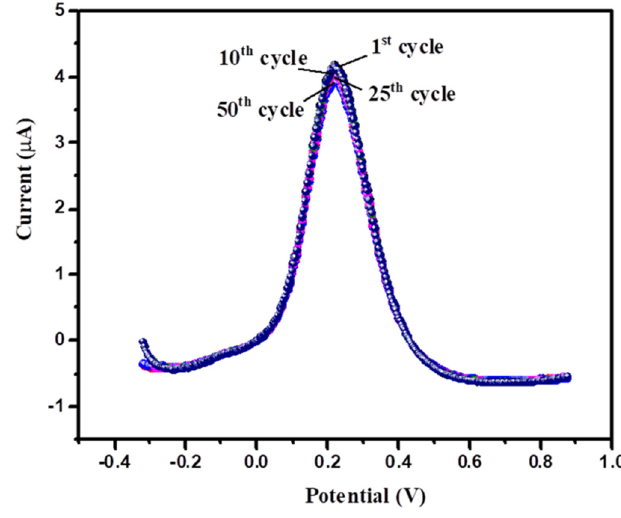
Figure 11. 1st, 10th, 25th, and 50th DPVs of MGCE in 20 µM of serotonin in 0.1 M PBS (pH = 7.0) at scan rate of 50 mV/s.